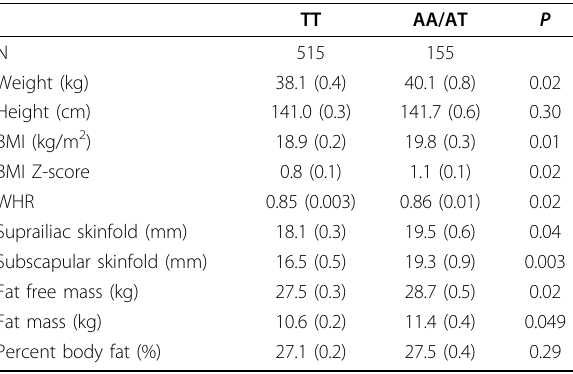
Table 3 Association of rs9939609 with obesity-related measures 1